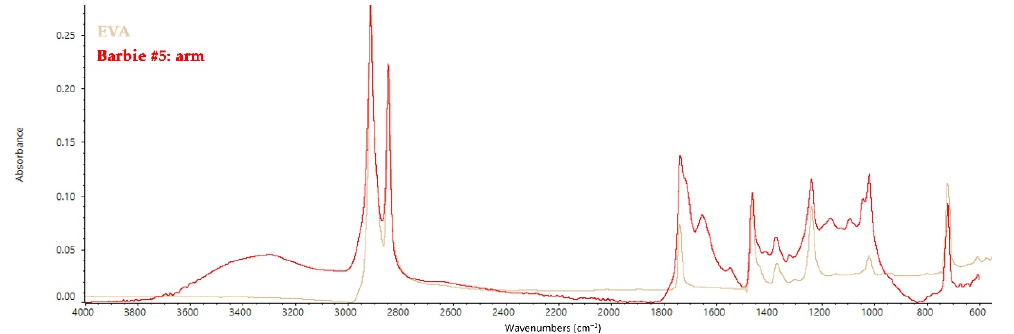
Figure 6. FT-IR ATR spectrum collected on the arm of Barbie #15 with the reference spectrum of EVA.